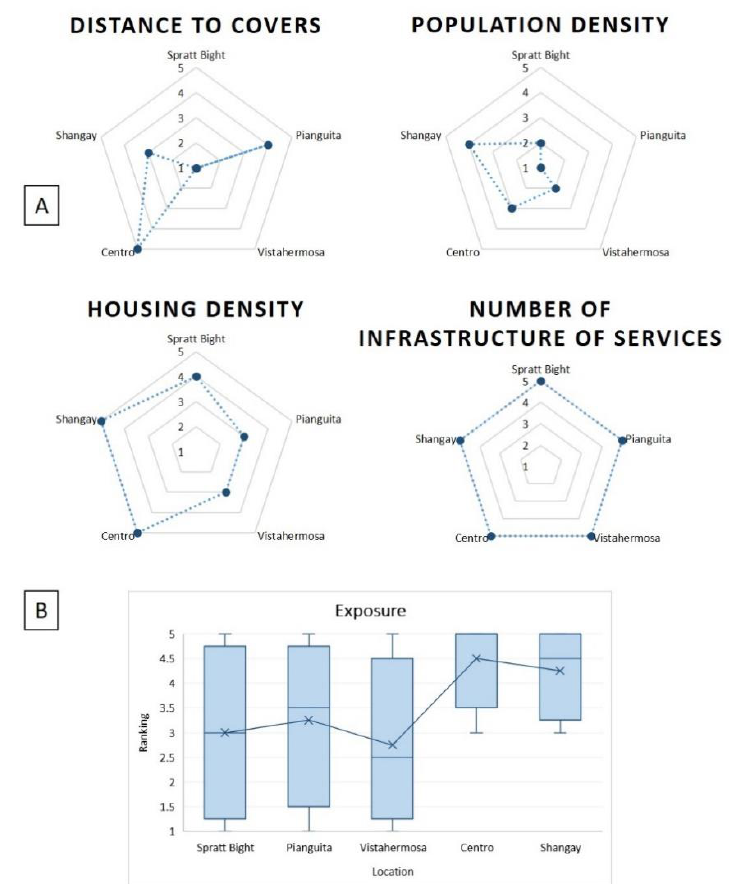
Figure 7. ( A ) Ranking of four variables representing exposure for two study areas (and five villages): San Andrés, Caribbean Coast (Spratt Bight) and La Bocana, Pacific Coast (Pianguita, Vistahermosa, Centro, Shangay) of Colombia. ( B ) Minimum and maximum values of exposure on each village and average rank. Results are shown by ranking, given that units of analysis are rank levels and not segments as it was in hazard.